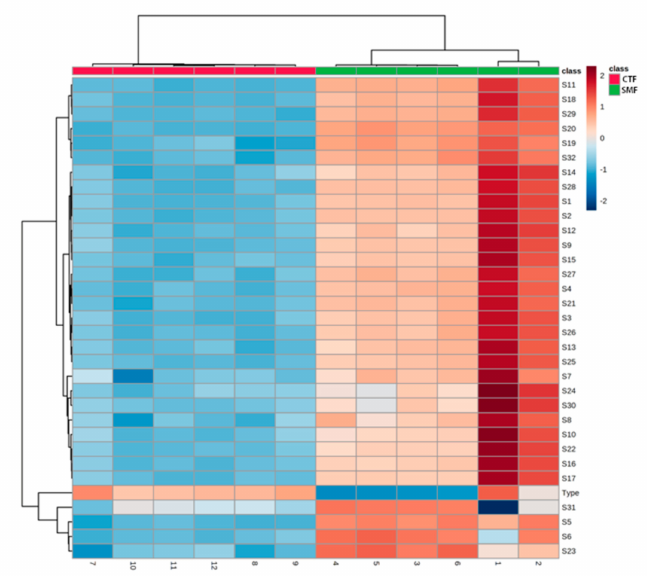
Figure 7. Heatmap of stable signals of e-nose sensors for six repetitions for each sample of F-MC produced with milk from two different dairy breeds (Holstein vs. Jersey). The blue frame indicates sensors with a negative correlation to the grade; the red frame indicates sensors with a positive correlation to the